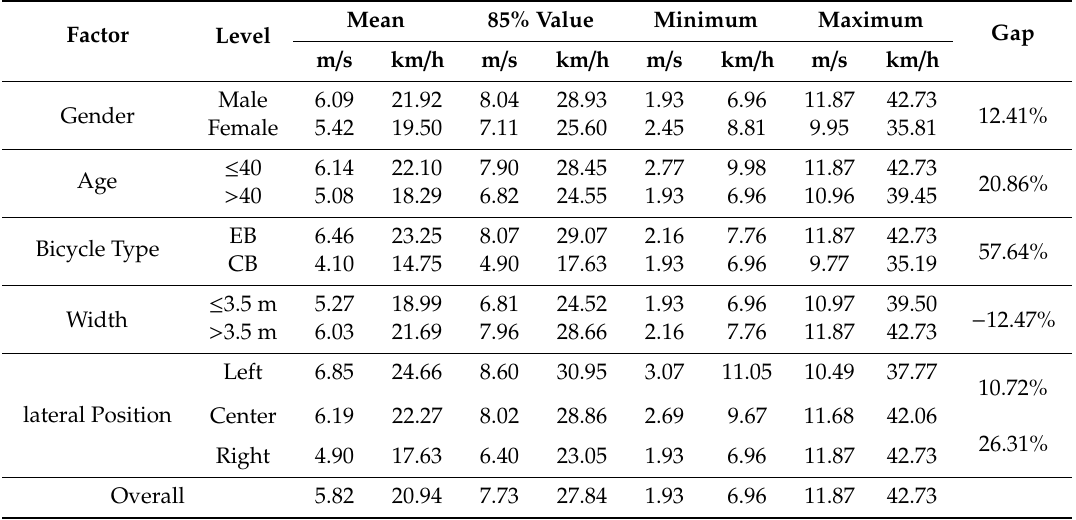
Table 7. Velocity Statistics by Gender, Age, Bicycle Type, Lane Width and Lateral Position.